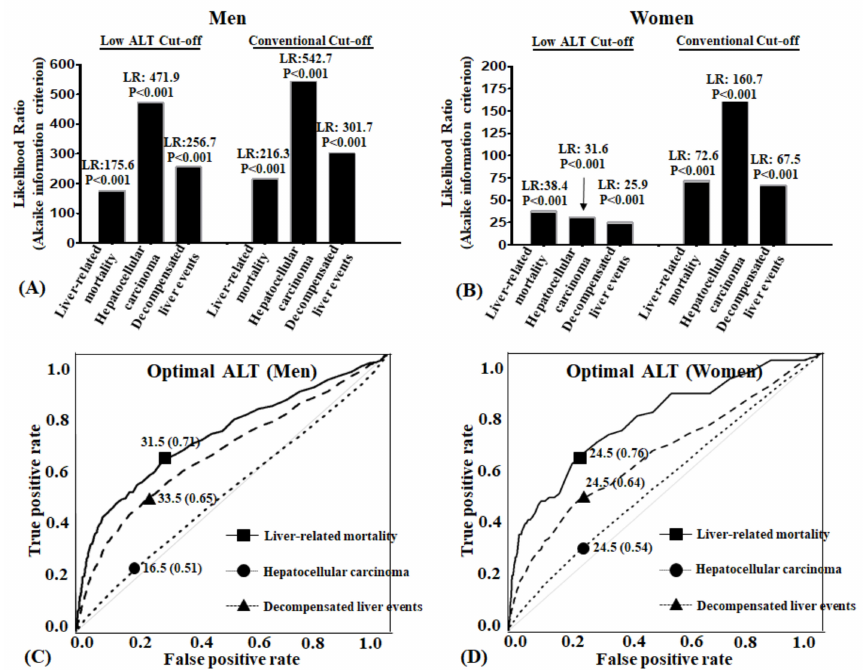
Figure 4. Likelihood ratio of mortality and morbidity and receiver operating characteristic curve according to ALT reference variables: ( A , B ) Cox proportional hazard regression models for likelihood ratio (LR) for liver outcomes according to two di ff erent alanine aminotransferase (ALT) cut-o ff values. All adjusted for age, BMI, smoking, exercise, alcohol consumption, fasting blood glucose, and cholesterol. LR, likelihood-ratio statistic: ∆ G2 = − 2 log L from reduced model( − 2 log L from current model). Reduced model is the control model. Current model is the cut-o ff model; ( C , D ) Optimal cut-o ff values of alanine aminotransferase for adverse liver